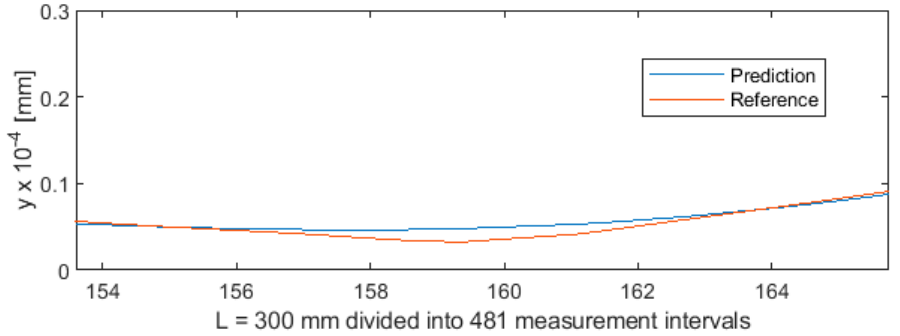
Figure 20. Machining quality prediction using MLP ANN—detail of the process for L = 154 ÷ 165 mm in Figure 19.